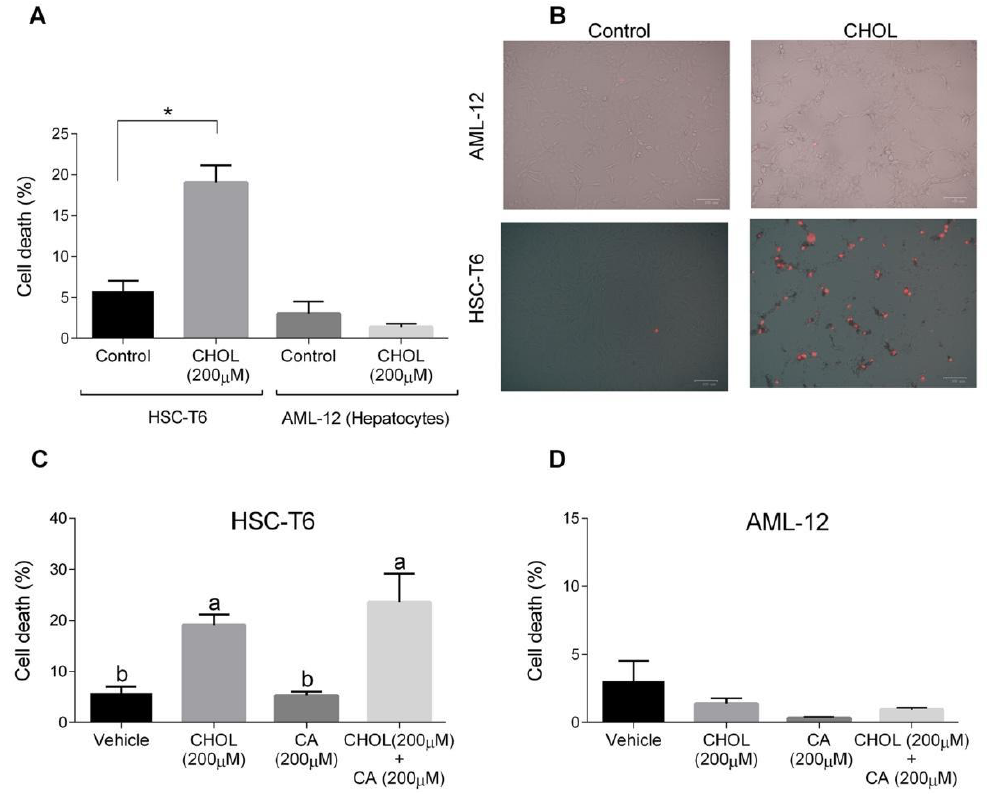
Figure 7. The effect of cholesterol and cholic acid on HSC-T6 and AML-12 viability. HSC-T6 and AML-12 cells were seeded in 96-well plates and exposed for 24 h to the control (treated only with cell media), vehicle group (treated with 0.1% DMSO), cholesterol (CHOL 200 µM), cholic acid (CA 200 µM) or cholesterol with cholic acid (CHOL 200 µM + CA 200 µM), n = 4. ( A ) Cell death in HSC-T6 and AML-12 cells. ( B ) Propidium iodide (PI) staining in HSC-T6 and AML-12 cells, following CHOL treatment; red spots indicate the loss of membrane integrity and cell death. ( C ) Cell death in HSC-T6 cells following CHOL and CA treatment. ( D ) Cell death in AML-12 cells following CHOL and CA treatment. All values are expressed as the mean ± SD; columns marked with different letters (a, b) are different ( p < 0.05) in the Tukey-Kramer post-hoc test; columns marked with * are different from the control or vehicle according to Student ’s t- test ( p < 0.05).